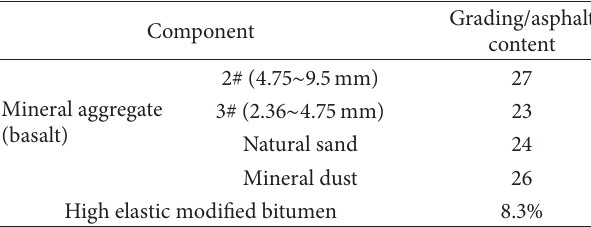
Table 3: Gradation composition of the asphalt